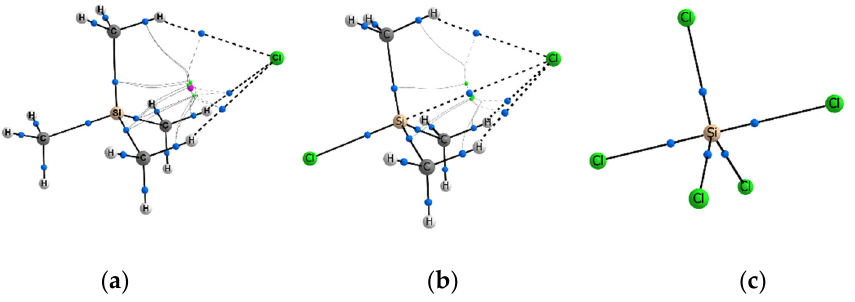
Figure 2. Different curvature of electron density and disposition of cp in complexes ( a ) CH 3 –Si(CH 3 ) 3 …Cl − ; ( b ) Cl–Si(CH 3 ) 3 …Cl − ; ( c ) Cl–SiCl 3 …Cl − .